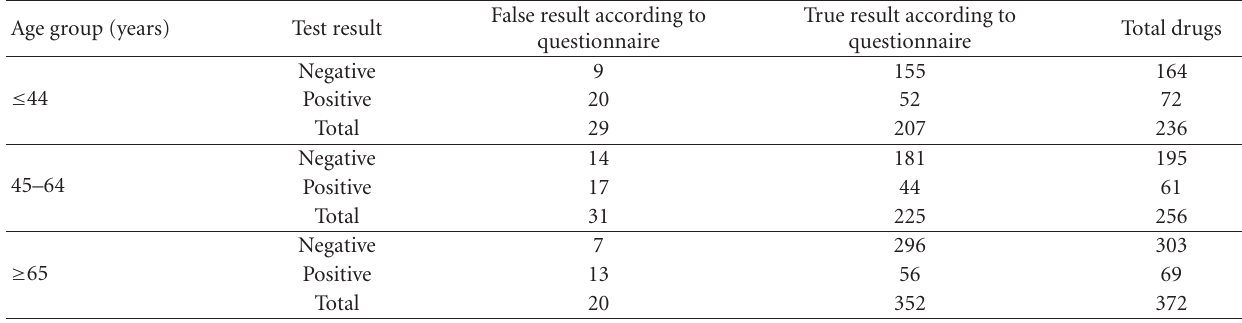
Table 4: Correlation between patient’s age and IFN-gamma release results for all medications.